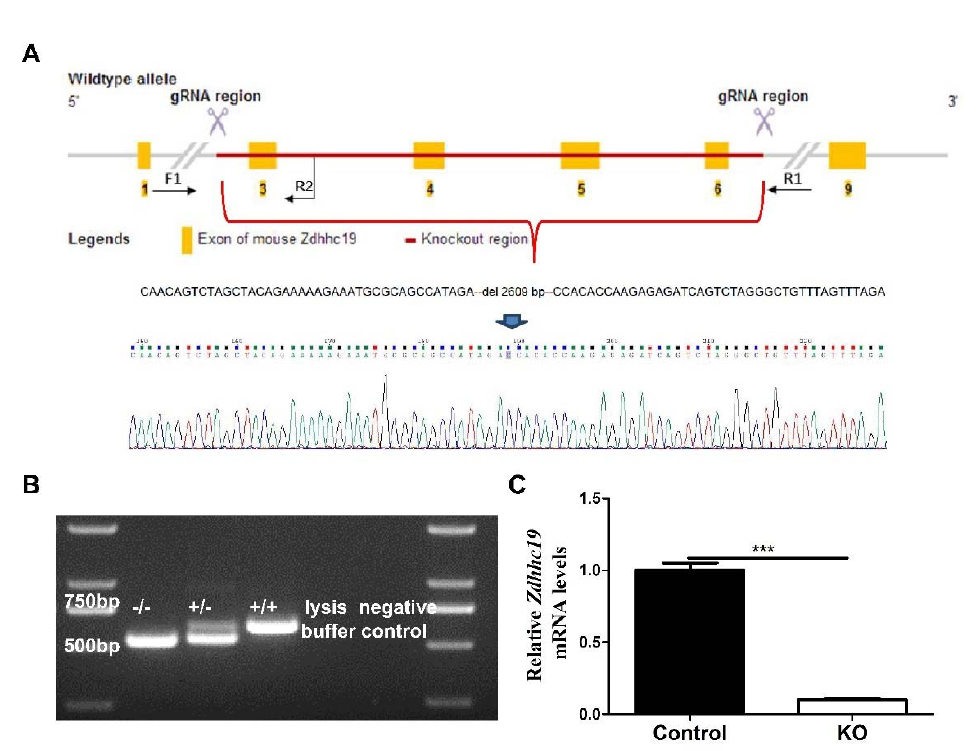
Figure 2. CRISPR/Cas9 strategy to generate Zdhhc19 KO mice. ( A ) targeting scheme of Zdhhc19 KO mice. Yellow boxes represent exons of the Zdhhc19 gene on mouse chromosome 16, and black arrows (F1, F2 and R1) indicate the site of designed primers for genotyping. Red line indicates the target regions of sgRNAs. Exon 3–6 was deleted upon the injection of the mixtures of Cas9 and Zdhhc19 sgRNA into zygotes. ( B ) PCR of wildtype (+/+), heterozygous (+/ − ), and homozygous ( − / − ). A 536bp band was amplified from the Zdhhc19 KO allele using F1 and R1 primers, and a 617bp band was amplified from the wildtype allele using F1 and R2 primers. ( C ) Zdhhc19 mRNA expression levels in control and Zdhhc19 KO adult testes were examined by RT-qPCR. Data are presented as mean ± SEM. *** p < 0.001.